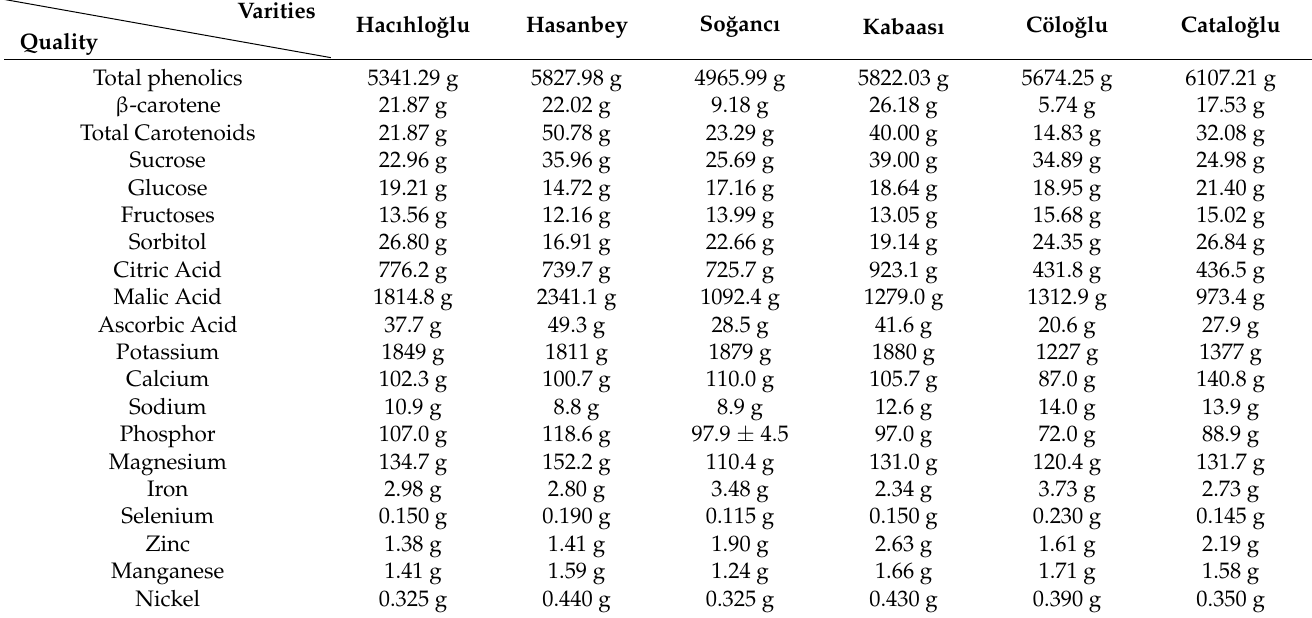
Table 2. The nutritional and chemical composition of some